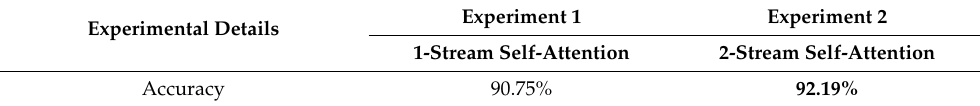
Table 5. Accuracy (in %) comparison of the proposed models with multistream self-attention [29].